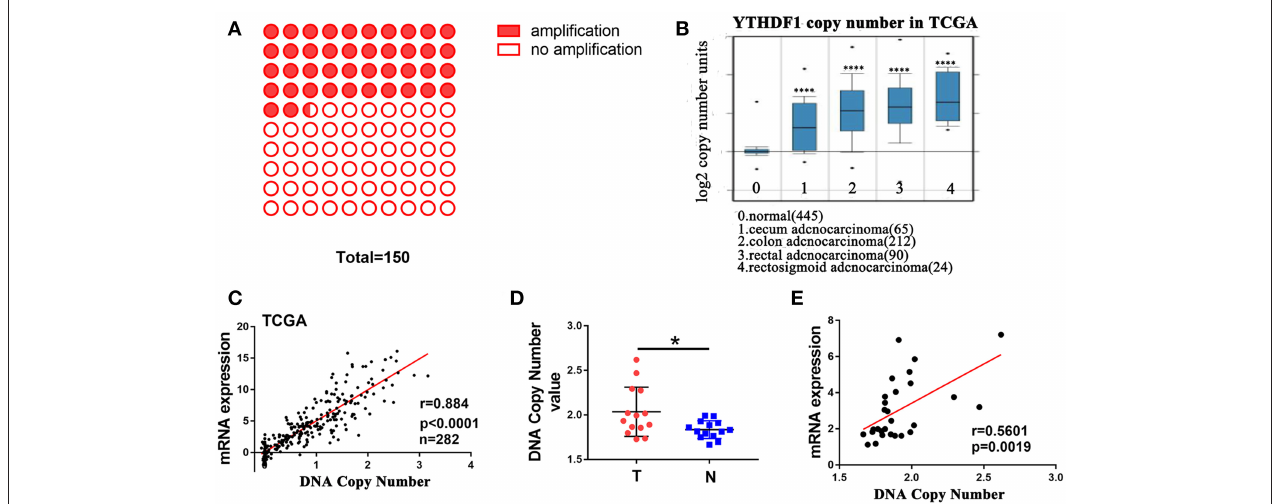
FIGURE 2 | DNA copy number amplification contributes to YTHDF1 overexpression in CRC. (A) 42% (64/150) CRC patients with increased YTHDF1 expression had an amplification of the YTHDF1 copy number. (B) YTHDF1 copy numbers in TCGA CRC samples. (C) Correlation between the DNA copy number and